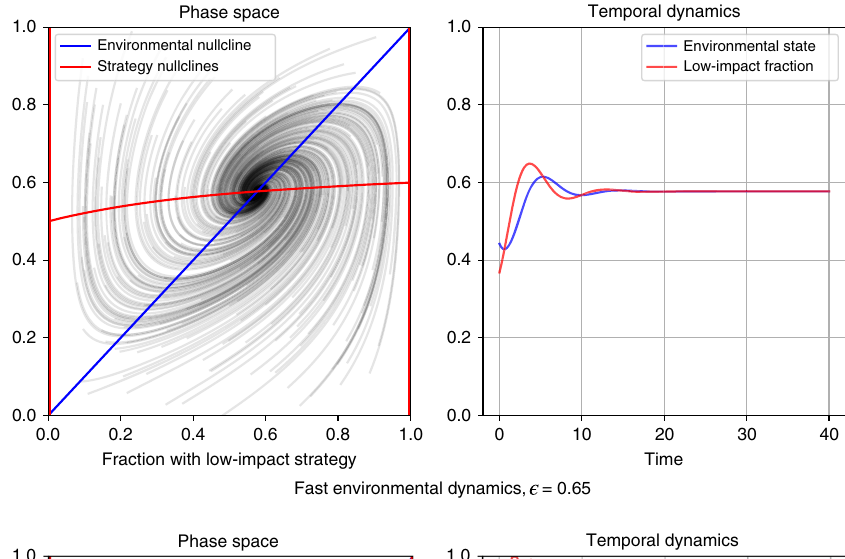
¼ 2 ; δ 0 ¼ 3 ; Δ 1 ¼ 1 ; δ 0 ¼ L H L H